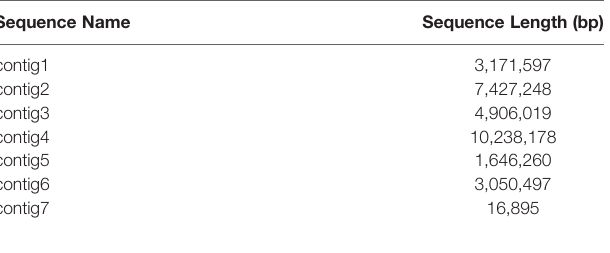
TABLE 2 | Statistics for the contig length of the A. mycotoxinivorans GMU1709 genome